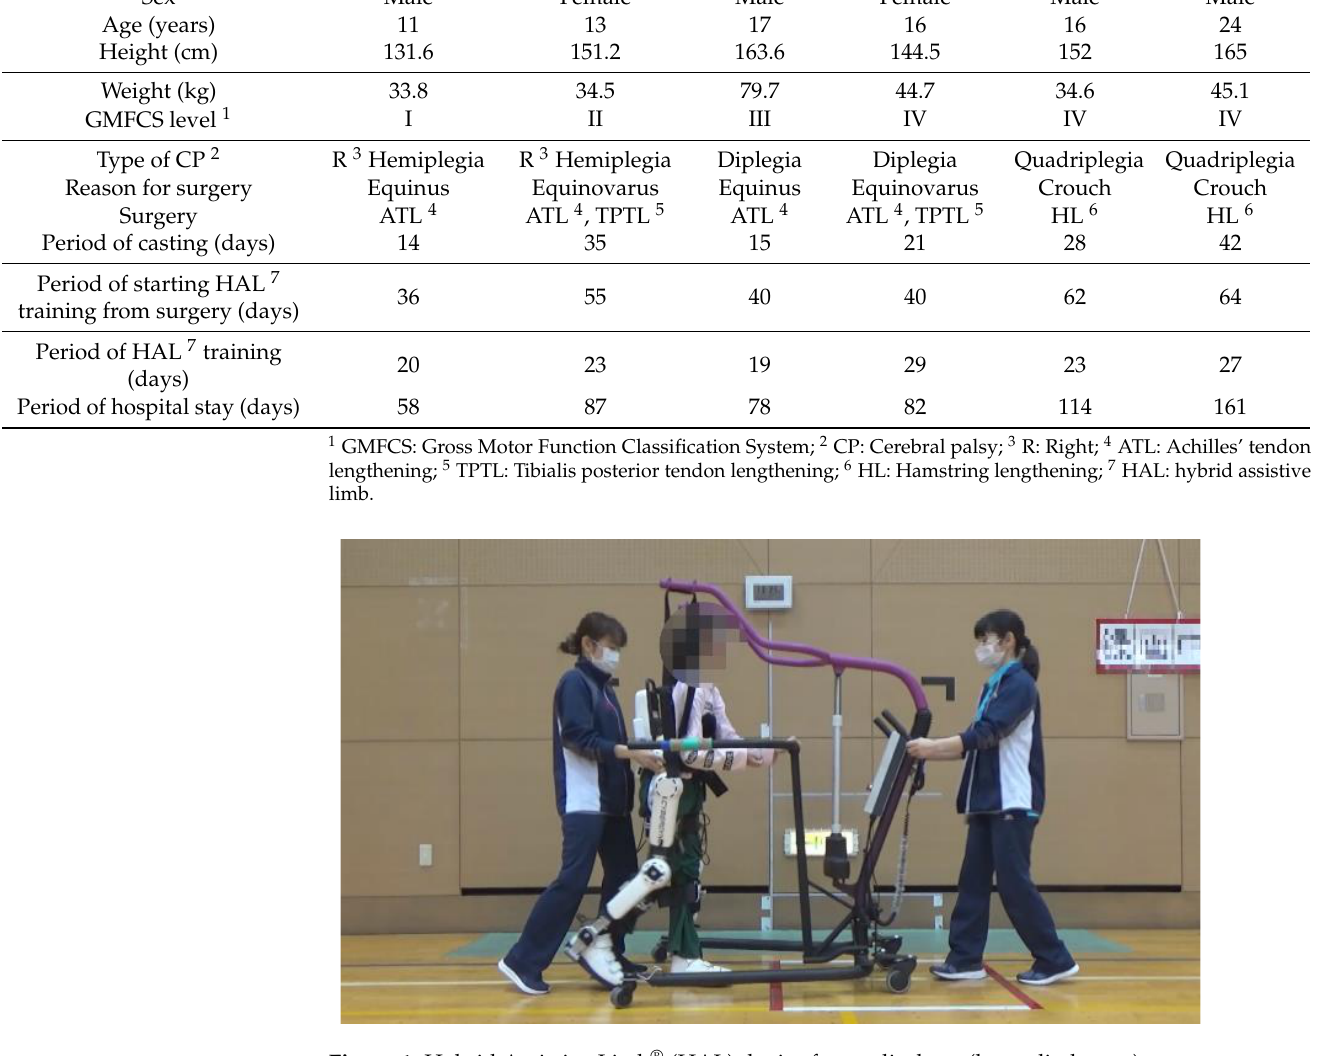
Figure 1. Hybrid Assistive Limb ® (HAL) device for medical use (lower limb type). While walking and wearing HAL, patients utilized a walking device (All-in-One Walking Trainer) with a harness for